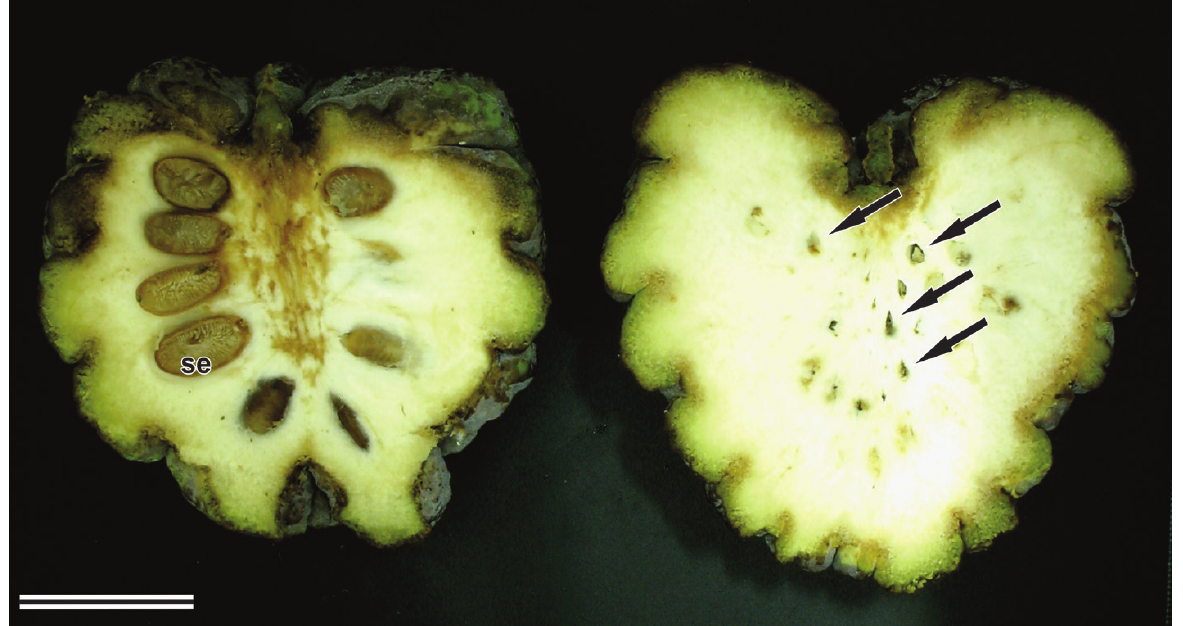
Figure 1 - Longitudinal sections of Annona squamosa fruits from normal (left) and aspermic mutant access, with the location of sterile seeds marked (arrows). se , seed. Scale bar: 3